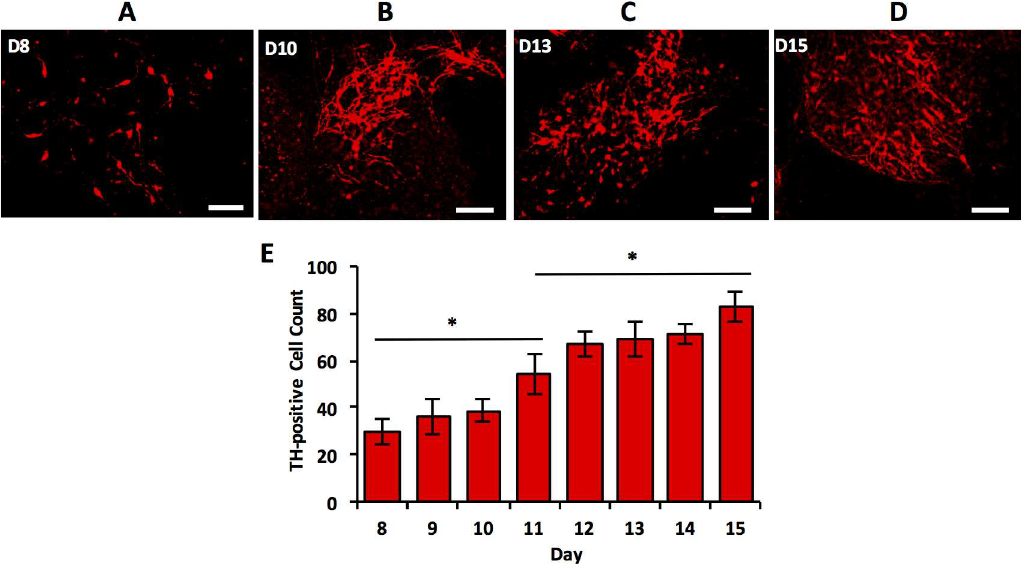
Fig 6. Immunocytochemical analyses of TH stained images. (A-D) Immunostainedimages of TH-positive dopaminergicneurons duringthe second week of co-culture of mESCs and PA6 cells. (E) The number of dopaminergic neuronsincreaseswith culture time. Scale bar: 100 μ m. * indicates p <